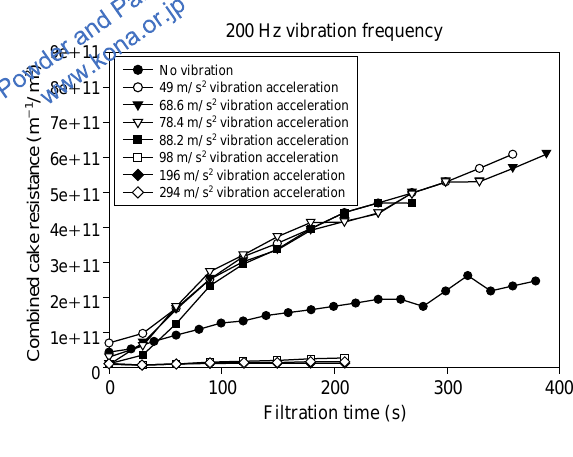
Fig. 9 Variation of the combined cake resistance with time dur- ing the vibration-assisted filtration process with the medi- um vibrating at 200 Hz.